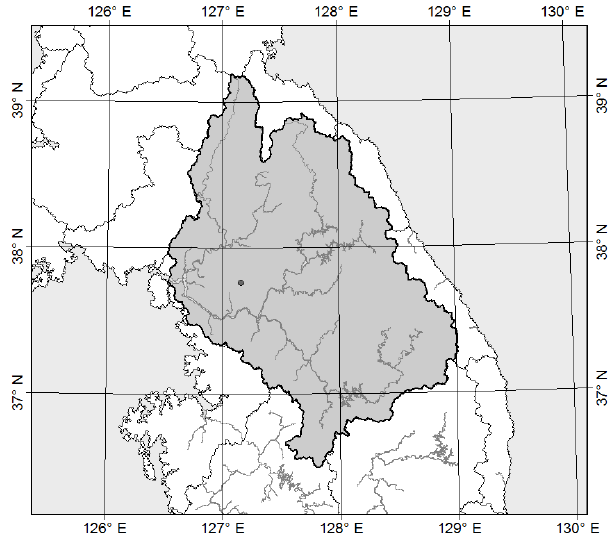
Figure 2. Geographic location of the Han River basin (dark shaded area) in South Korea. The gray lines in the basin indicate the river